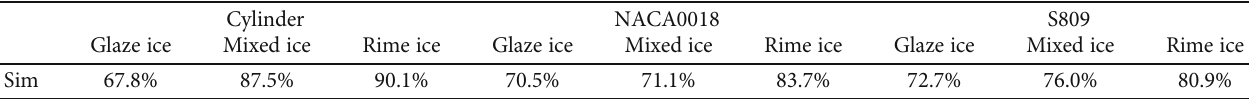
Table 4: Asymmetric airfoil icing